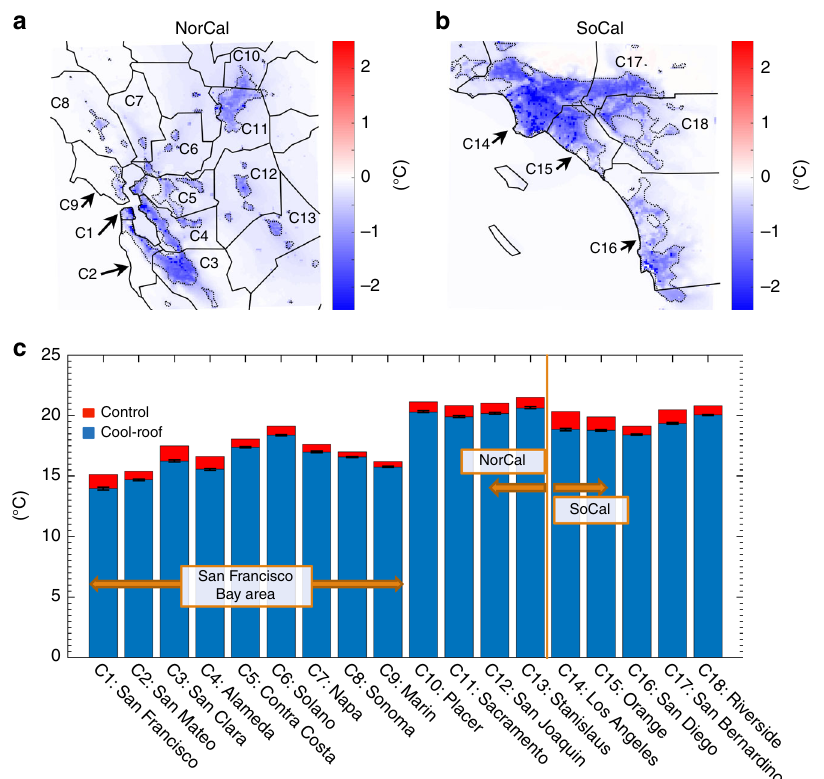
Fig. 4 Simulated cool-roof-induced changes in 2-m air temperature. a , b Cool-roof-induced air temperature changes for NorCal and SoCal, respectively. c air temperature for control and cool-roof simulations for each county. Values represent averages over June – October of 2001 – 2015. The error bars in c illustrate inter-annual fl uctuations of air temperature changes induced by cool roofs. The solid black lines in a , b illustrate the boundaries of the 18 urban counties that are captured in the model domains. The boundaries of urban surfaces are illustrated by dotted black lines. Note that only changes that are statistically distinguishable from zero at 95% con fi dence interval are included